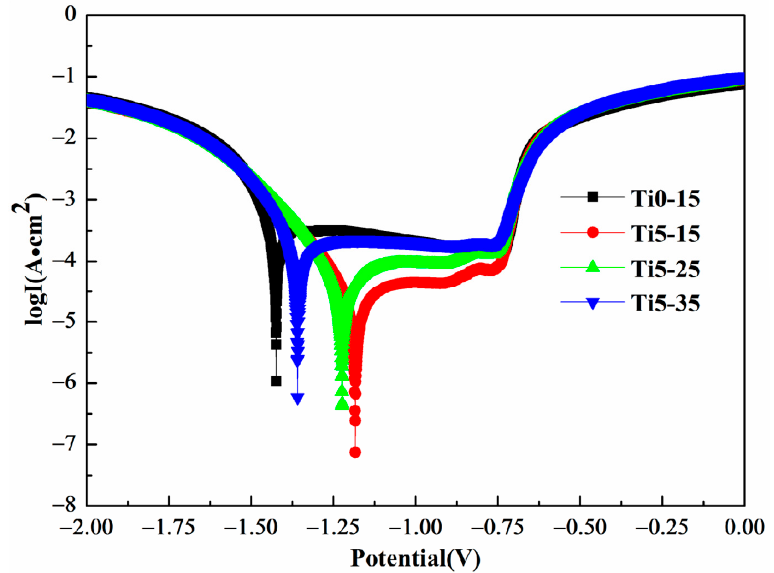
Figure 7. XPS diagram of Ti5 ‐ 15 MAO film.